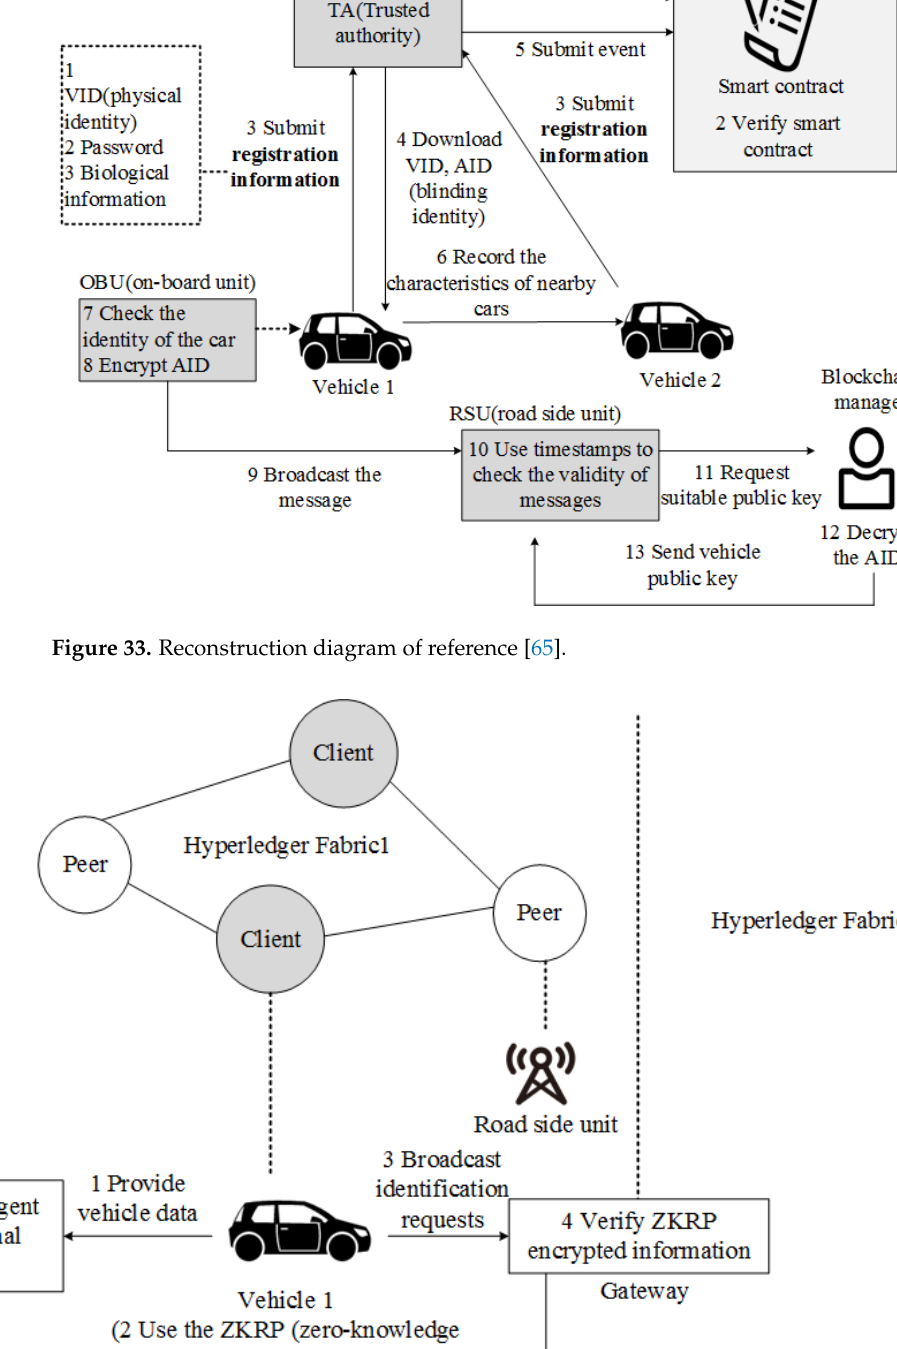
Figure 35. Reconstruction diagram of reference [67]. To address the traffic safety problem at intersections, Buzachis [68] proposed a sys- tem for monitoring vehicles at intersections based on Hyperledger (Fabric). In Figure 36, the trajectory of the vehicle is simulated in real time by chaincode and the endorsement node is responsible for detecting the simulation results. The usability of the system is demonstrated by testing self-driving vehicles through intersections at 1 – 2 intersections,